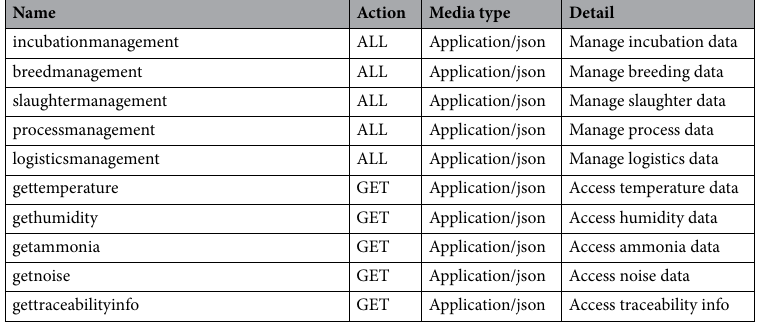
Table 5. Restful API list.